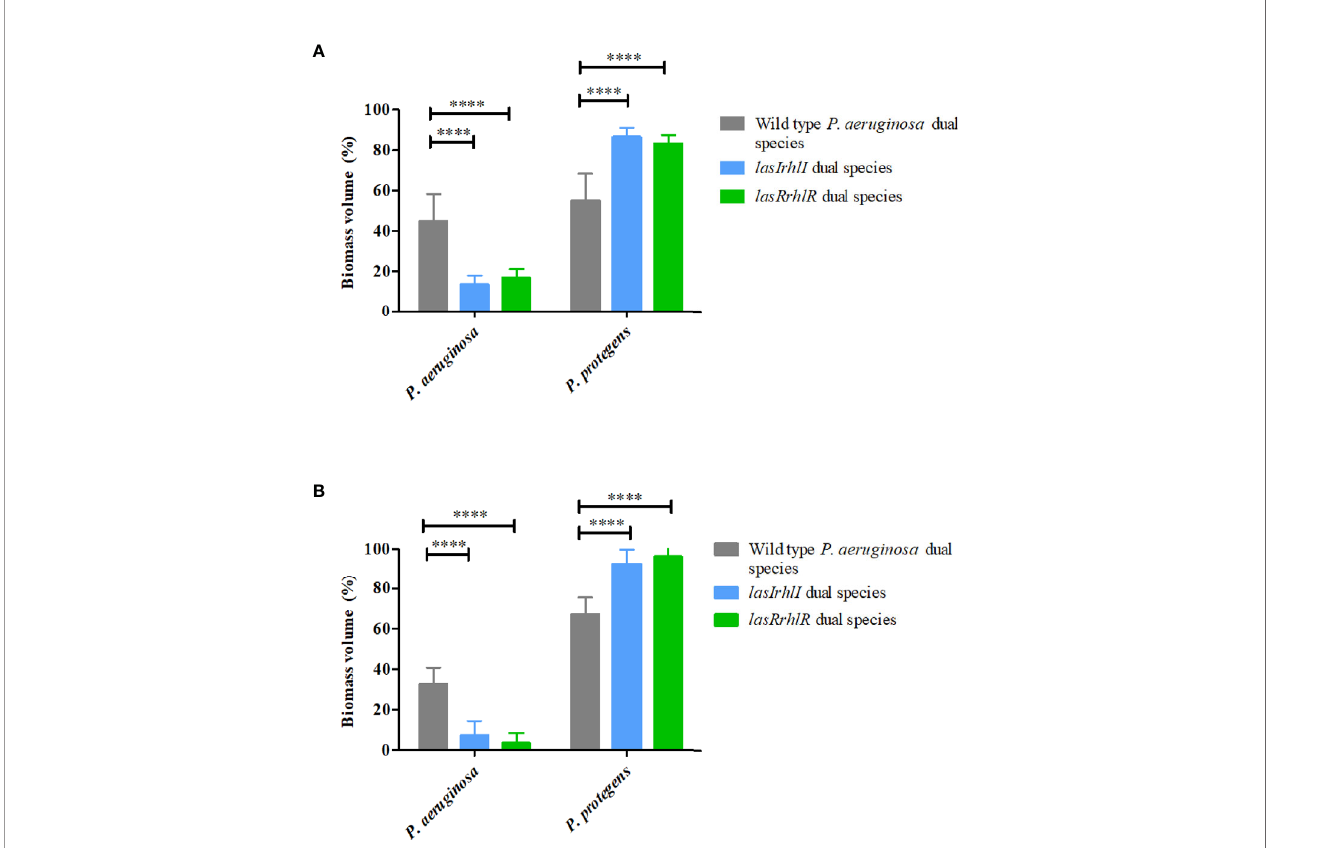
FIGURE 3 | Proportions of P. protegens – P. aeruginosa dual-species bio fi lm. The proportions of the two species in the dual species bio fi lm containing either the P. aeruginosa wild type or the QS mutants ( lasIrhlI or lasrRrhlR ) after (A) 3 days and (B) 4 days of cultivation. Bar charts depict the percentages of P. protegens and P. aeruginosa in the wild type or QS mutant dual species bio fi lm. The proportions were derived by cultivating bio fi lms under fl ow cell conditions followed by quantitative image analysis of two independent biological replicates. Error bars represent standard deviations (n =2). **** denote signi fi cant difference by two-way ANOVA followed by Tukey ’ s post-test ( P <